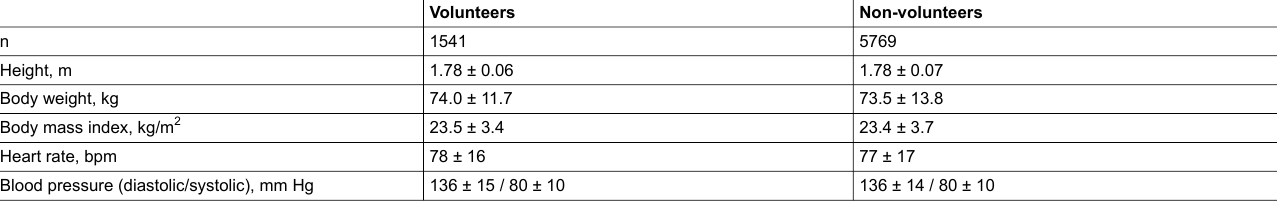
Table 1: Characteristics of Swiss-Italian conscripts who had respectively had not volunteered to participate in the study between 2009 and 2013. Results are given as mean and standard deviation. No statistically significant differences were noted between the two groups. Volunteers